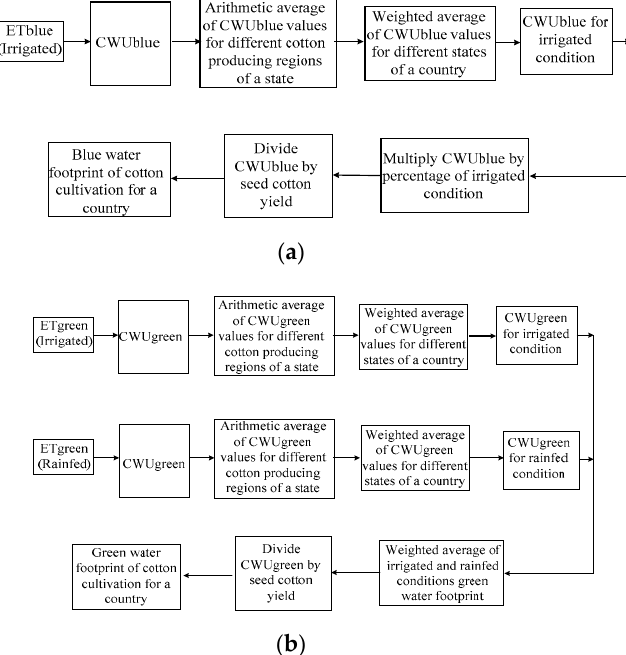
Figure 2. Flow diagram for calculation of ( a ) blue water footprint of cotton farming and ( b ) green water footprint of cotton farming for a country (recreated from [31]).